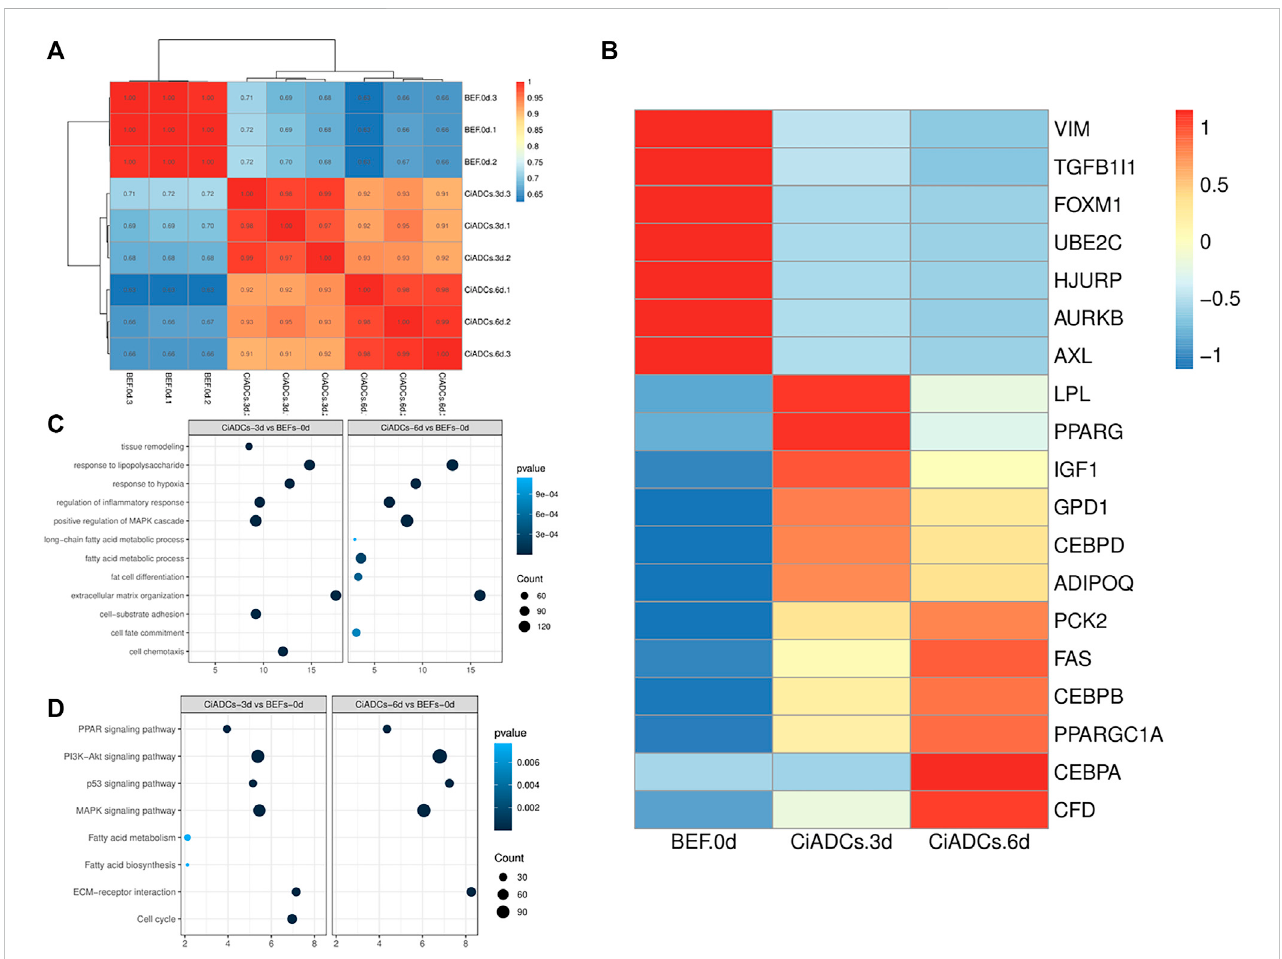
Identi fi cationofdifferentiallyexpressedgenesenrichedinthetransdifferentiationintoadipocytes (A) HeatmapofBEFs,CiADCs-3d,andCiADCs-6dcells gene expression correlation coef fi cients in mRNA-seq data. (B) Heatmap of the differentially expressed genes. (C) GO functional enrichment analysis of the upregulated DEGs. (D) KEGG adipogenesis pathway analysis of CiADCs-3d and